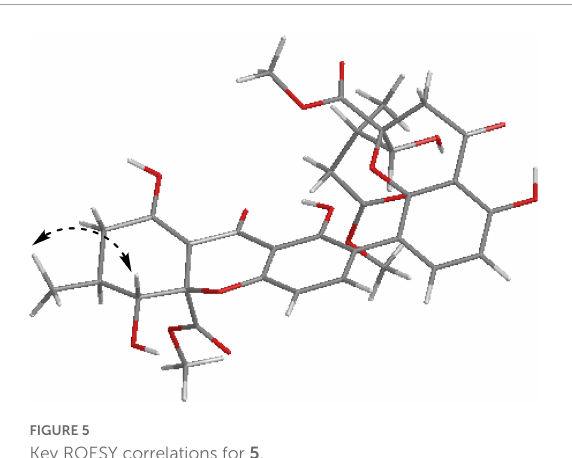
FIGURE5 Key ROESY correlations for 5